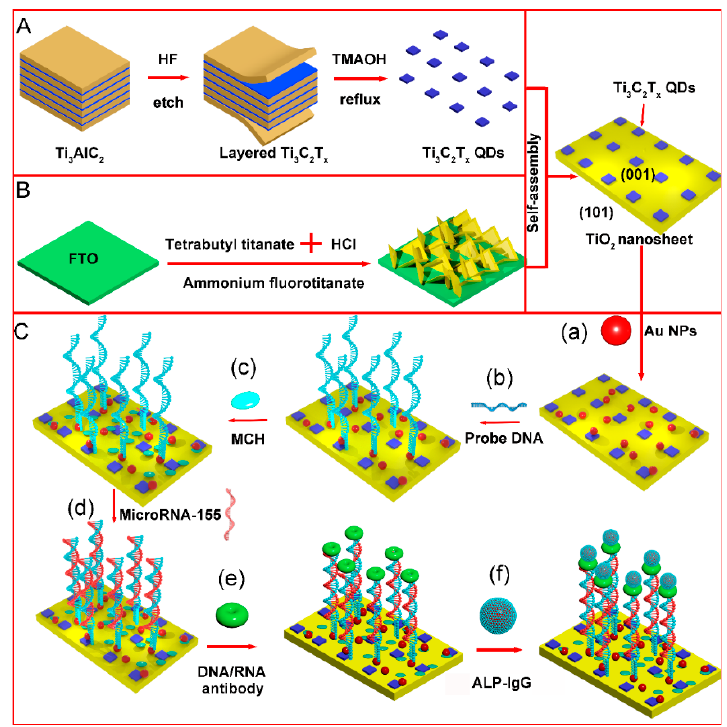
Figure 1. Schematic of PEC electrode construction and detection mechanism of microRNA-155 ( A ) synthesis process of Ti 3 C 2 T x QDs ( B ) synthesis process of (001) TiO 2 /FTO electrode ( C ) detection process of microRNA-155 ( a ) dropping AuNPs ( b ) probe DNA loading ( c ) incubation with MCH ( d ) incubation with microRNA-155 ( e ) incubation with antibody ( f ) incubation with IgG-ALP.